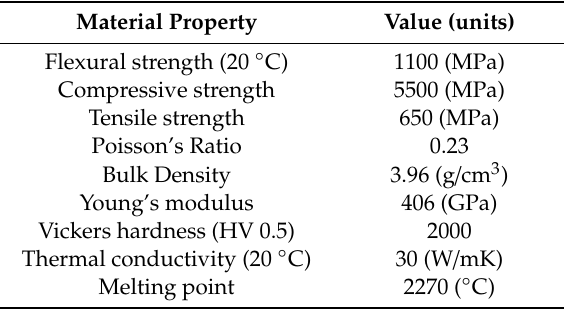
Table 1. Workpiece material characteristics (as provided by the manufacturer [34] ).